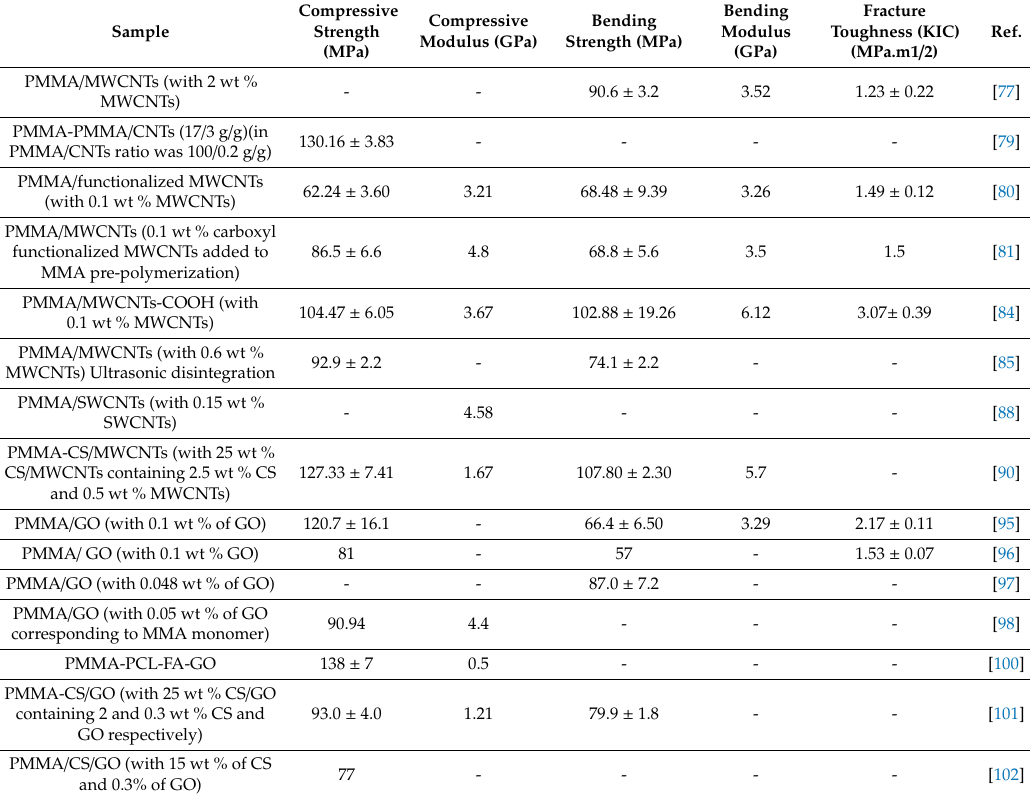
Table 1. Mechanical properties of the PMMA-based BCs containing CNTs (MWCNTs and SWCNTs), CS / MWCNTs, GO, PCL-FA-GO and CS / GO reinforcing agents. Compressive Sample Strength